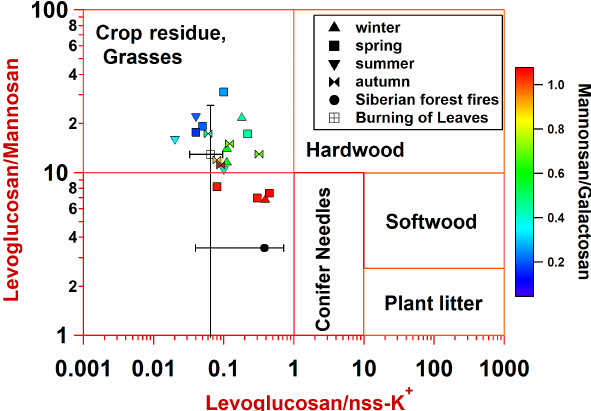
Figure 5. Scatterplot of levoglucosan / K + (Lev / K + ) versus levoglucosan / mannosan (Lev / Man) ratios in TSP collected over Gosan during April 2013–April 2014. The data for Siberian forest fires and burning leaves were adopted from Sullivan et al.